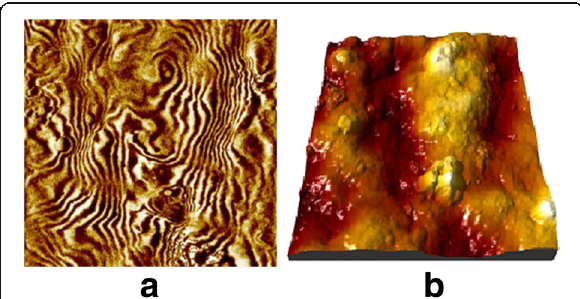
Fig. 2 Surface images with magnetized regions in the KTaO 3 nanocrystals. a Magnetic field gradient mapping and b surface relief image